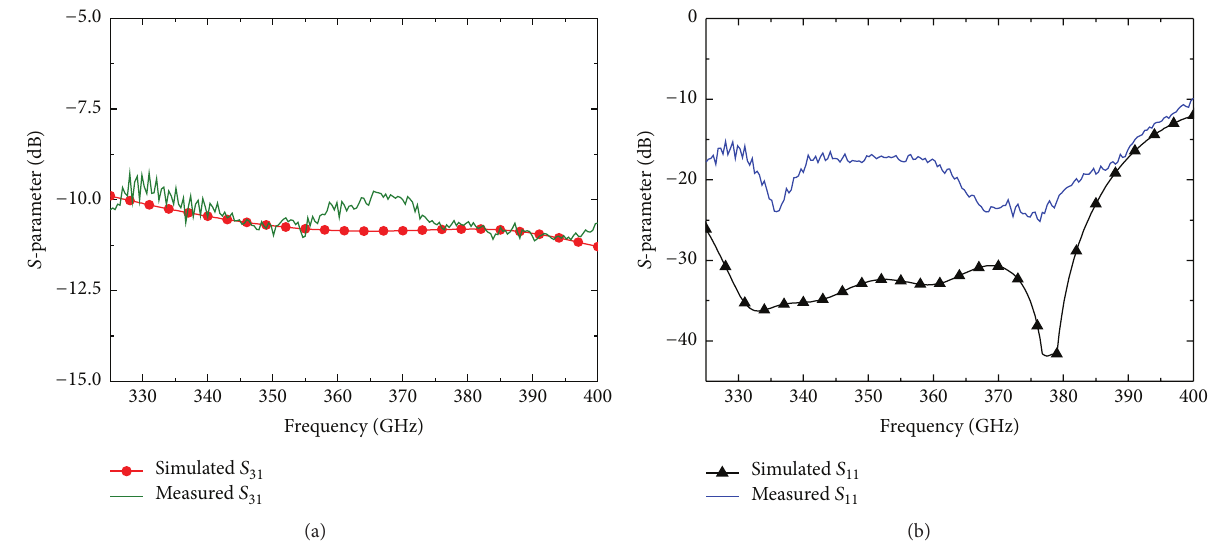
Figure 12: Measured (a) 𝑆 31 and (b) 𝑆 11 compared with measured and simulated results of the parallel coupling